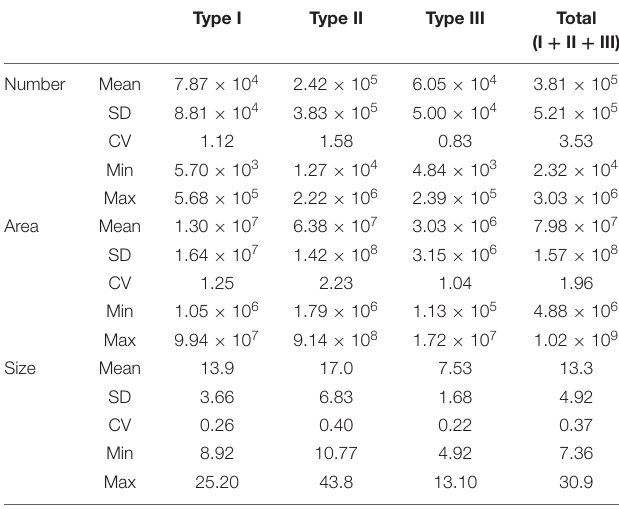
TABLE 2 | Summary of the means and variability in transparent exopolymer particle (TEP) parameters [number (particles L − 1 ), area ( µ m 2 L − 1 ), and mean diameter ( µ m)] for each TEP type and total TEPs; n = 56.